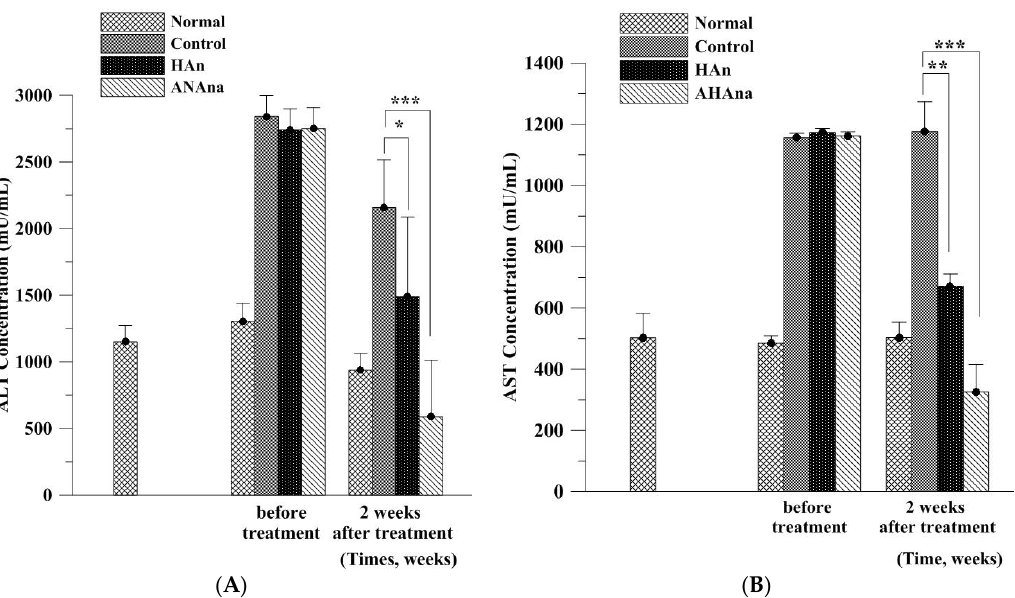
Figure 6. Serum biochemical analysis of liver function for the rats in the presence or absence of HAn and AHAna treatment. Comparison of serum alanine aminotransferase (ALT) ( A ) and aspartate aminotransferase (AST) ( B ) level between experimental groups and negative control was assessed. Both injective HAn and AHAna treatments reduced ALT and AST values while AHAna injection exhibited the strongest effects on hepatic function improvement in terms of serum biochemical measurement. Values are mean ± SEM ( n = 3; * p < 0.05, ** p < 0.01 and *** p < 0.001, by ANOVA).